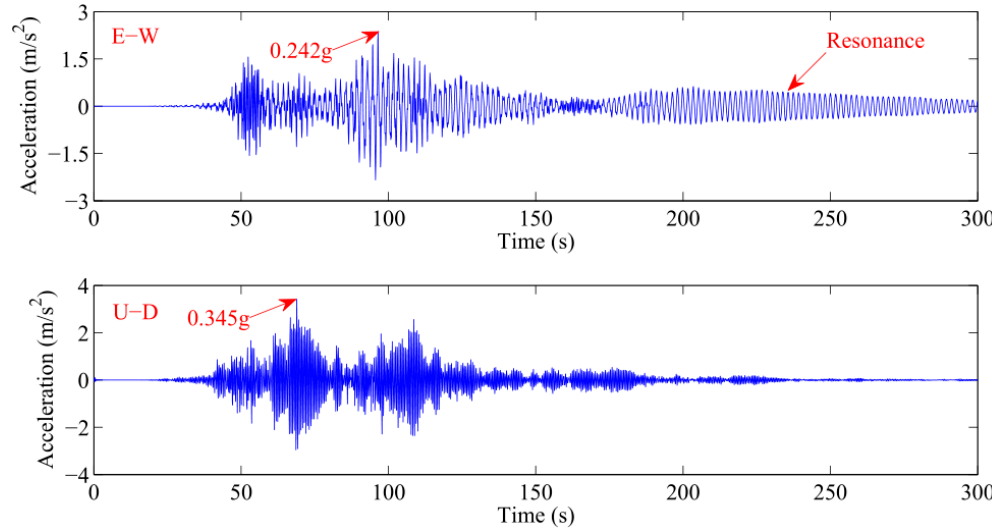
Figure 6. Time history of acceleration of the pipeline responding to input seismic wave. It is shown